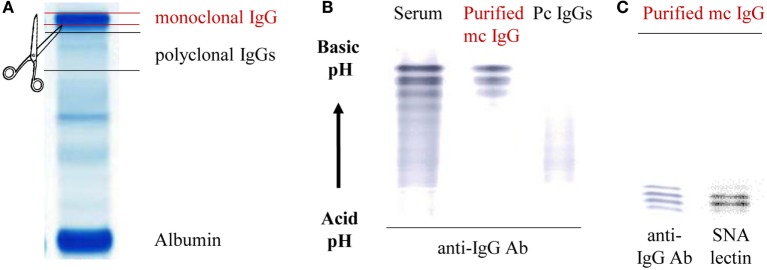
Purification scheme of mc IgGs from the serum of monoclonal gammopathy of undetermined significance (MGUS) and multiple myeloma (MM) patients. (A) Mc and pc IgGs from MGUS and MM patients were submitted to high-resolution agarose gel electrophoresis and then cut from the gel. (B) The purity of mc and pc IgGs was checked via isoelectro-focalization (IEF) and immunoblotting using a peroxydase coupled to an anti-human IgG-γ chain antibody (HRP anti-human IgG Ab). (C) The sialylation of mc IgG was assessed after incubation with biotinylated Sambucus nigra agglutinin (SNA) and streptavidin peroxidase. (B,C) are representative of purified basic or acid mc IgG, respectively.